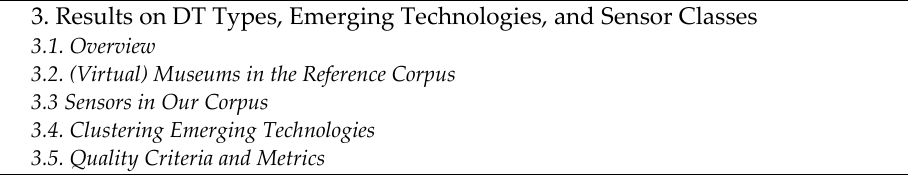
Figure 4 . Section 3, subsections and topics. Figure 4. Section 3, subsections and topics.